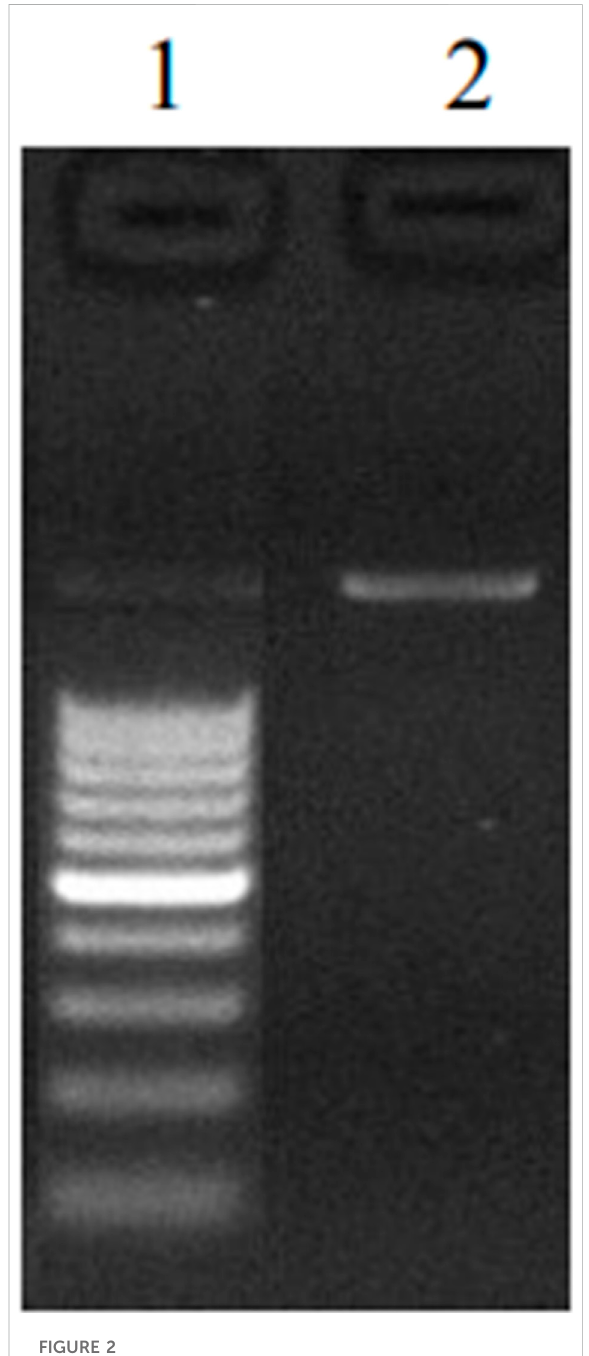
FIGURE 2 1.2% Agarose gel showing single 1500 bp of 16S rDNA amplicon. Lane 1: 100bp DNA ladder; Lane 2: 16S rDNA